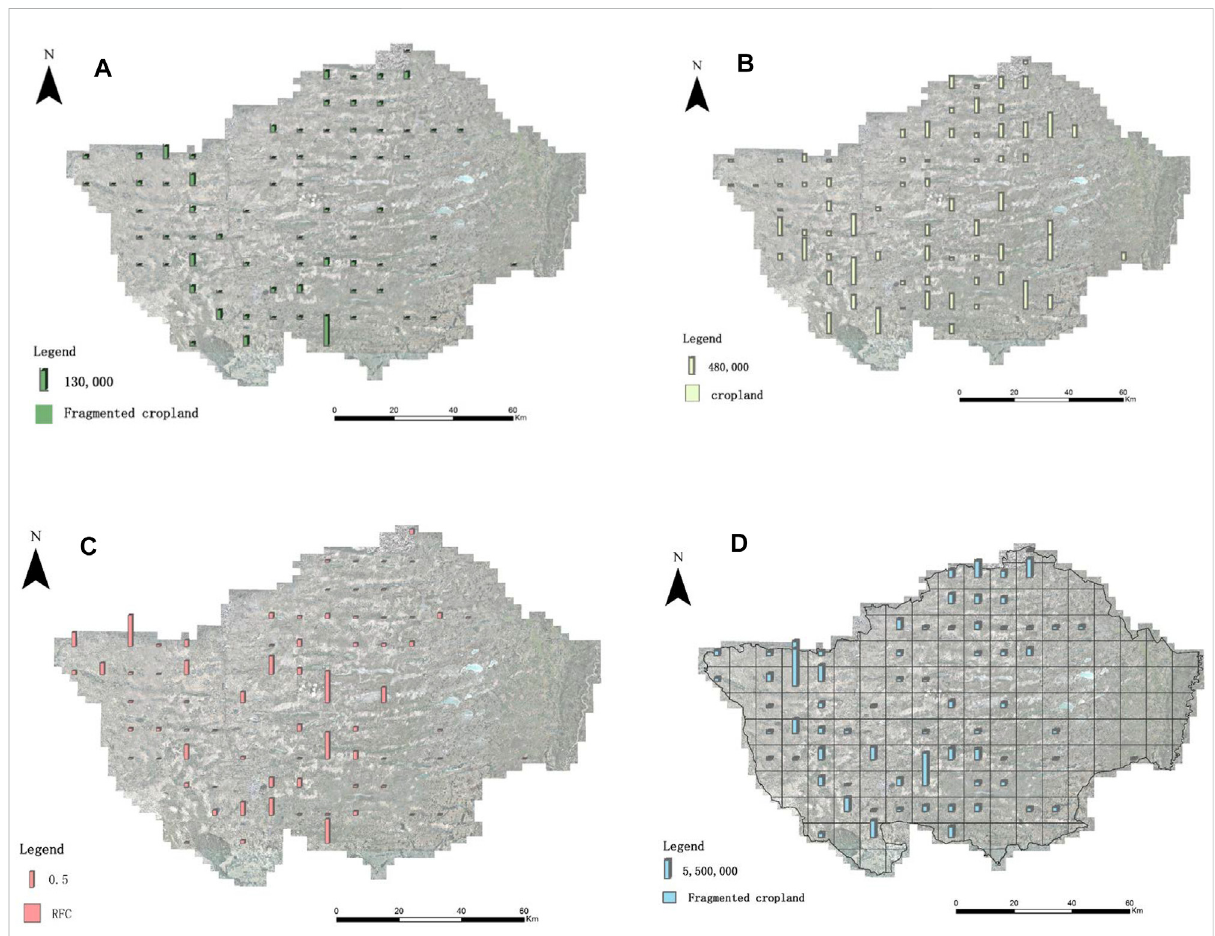
FIGURE 3 Identi fi cation results. (A) Area of fragmented cropland in the sample points; (B) area of cropland in the sample points; (C) RFC for each sample point; (D) area of fragmented cropland in the sample